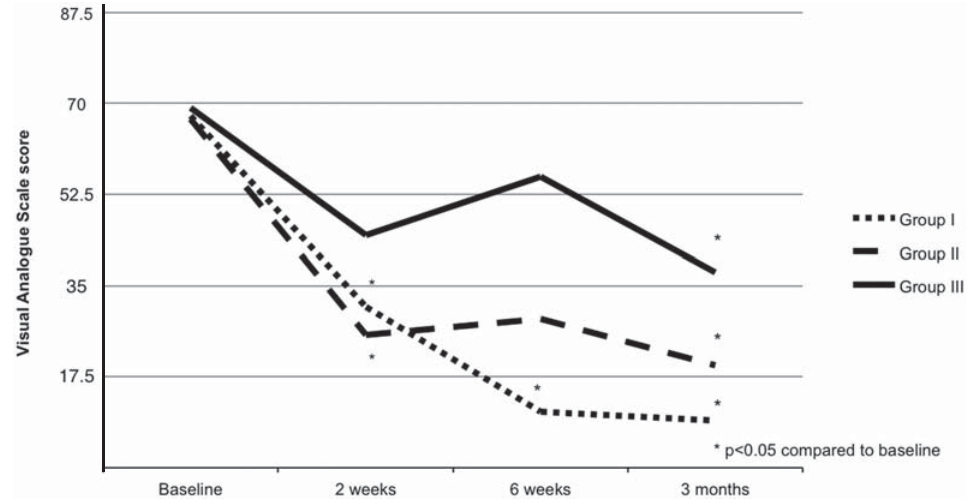
Figure 2- Pain intensity for the three groups at different times with intra-group ANOVA analysis